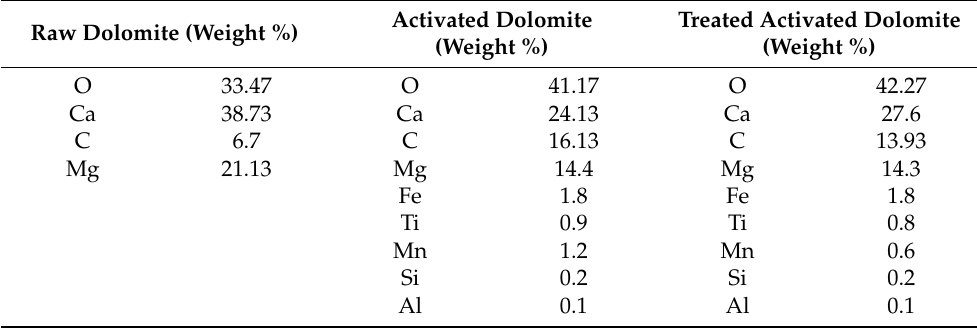
Figure 2. The comparison between raw dolomite (RD) and activated dolomite (AD) and their physical properties (down). Table 1. The energy dispersive X-ray analysis (EDX) on raw dolomite (control), activated dolomite (control) and treated activated dolomite in RTDW and STDW treatment.